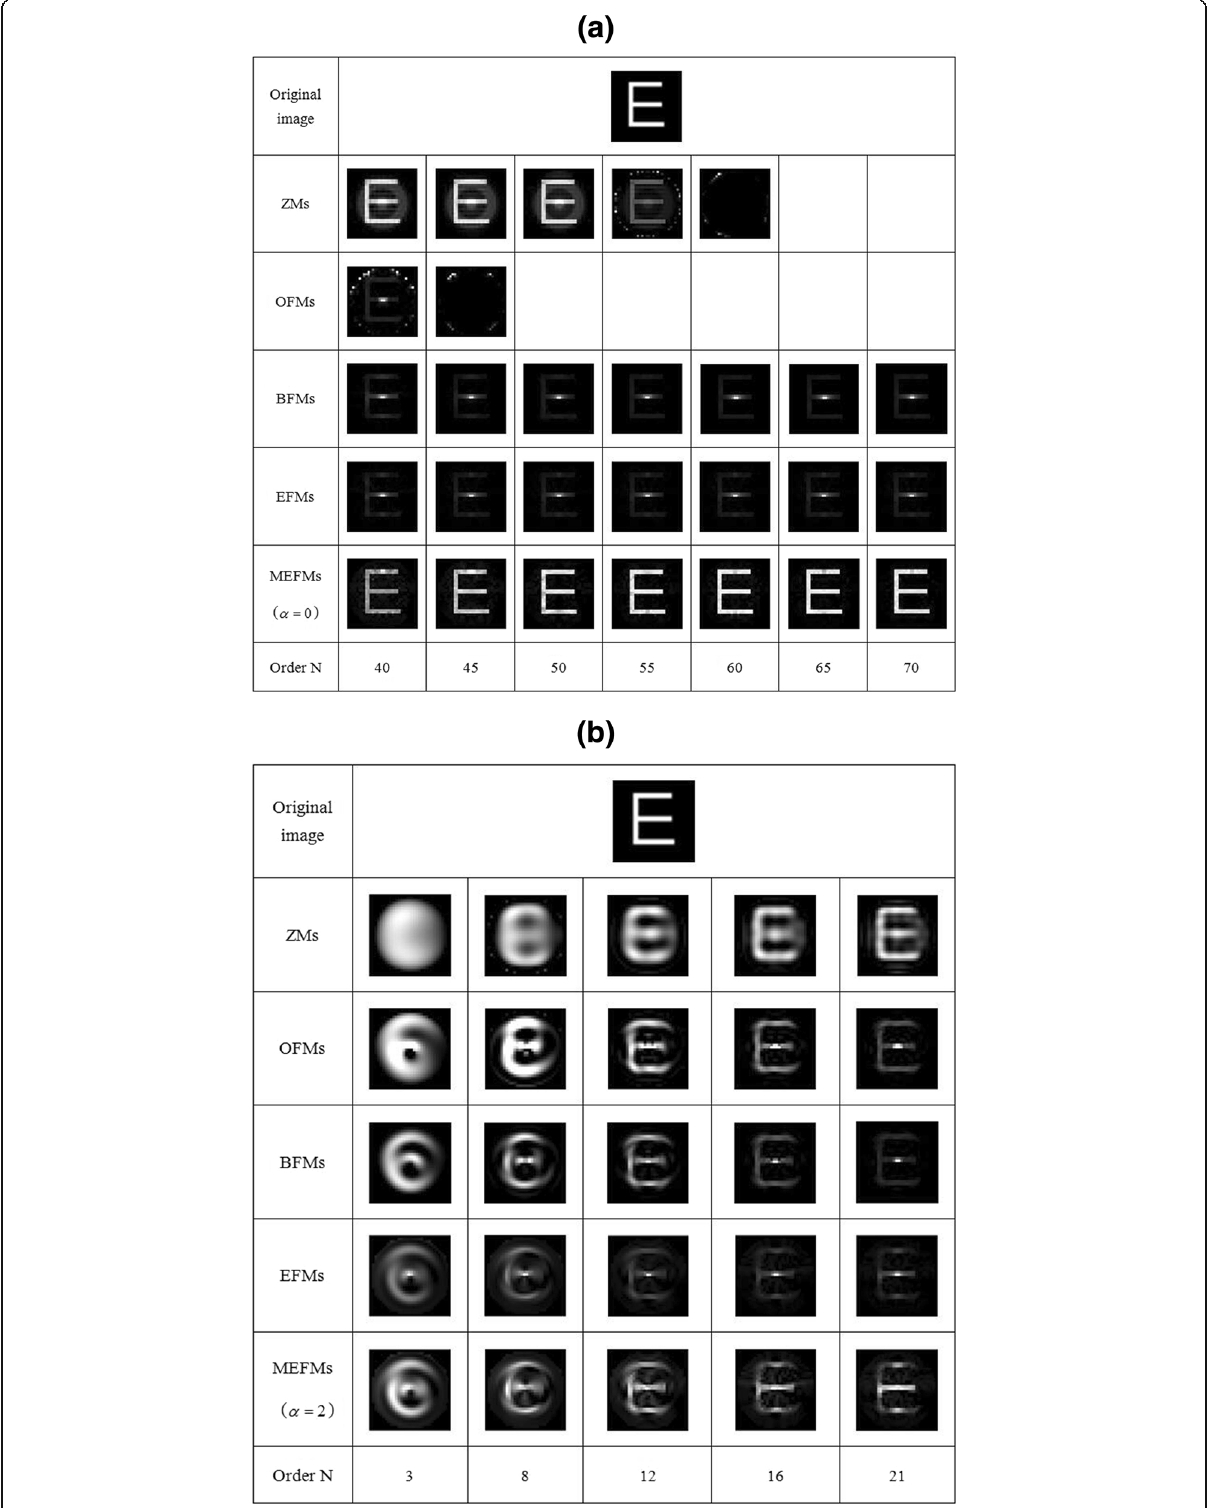
Fig. 11 a , b Uppercase English letter “ E ” are reconstructed in parameters ( α = 0 and α = 2 ) under different moments (MEFMs, ZMs, OFMs, and